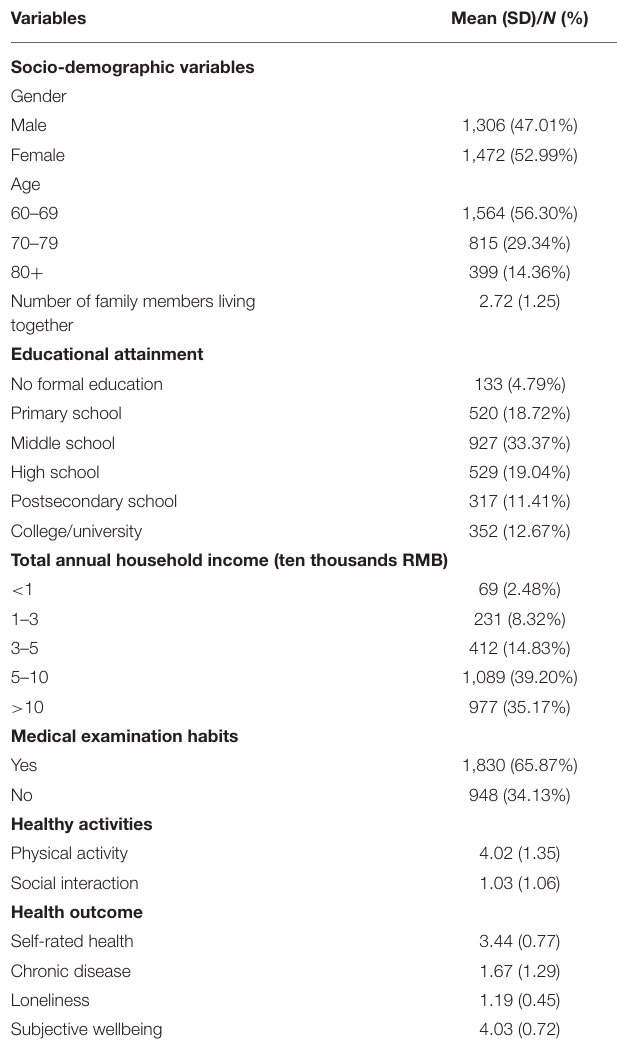
TABLE 2 | Descriptive statistics of the study population ( N =